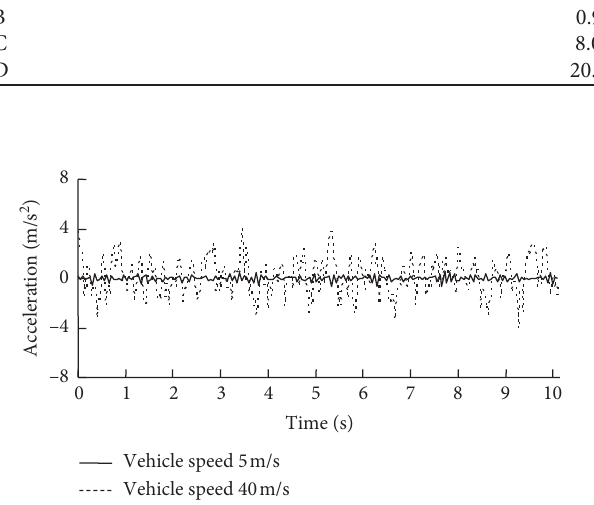
Figure 15: The time-history curves of vertical vibration acceler- ations of the vehicle body.